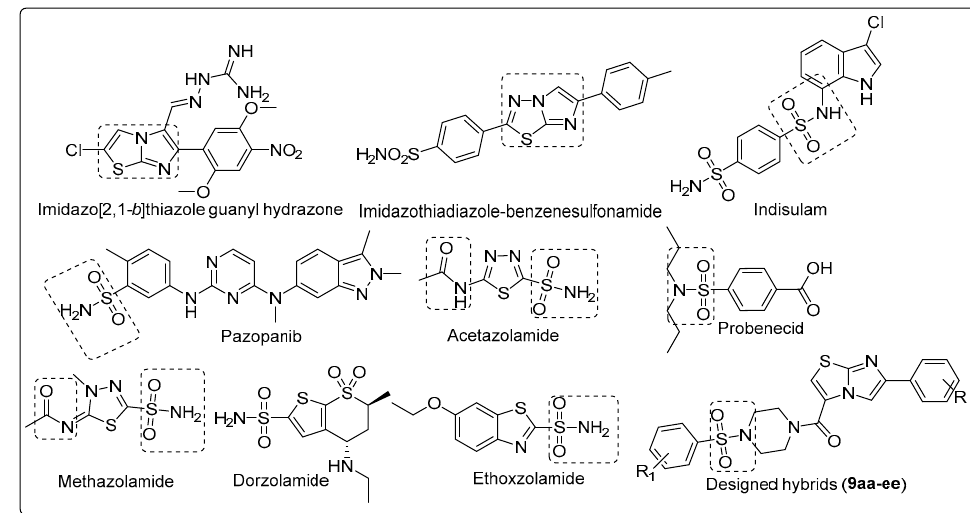
Figure 1. Representative examples of imidazothiazole, imidazothiadiazole, sulfonamides as CAIs and rationale for designed hybrids.